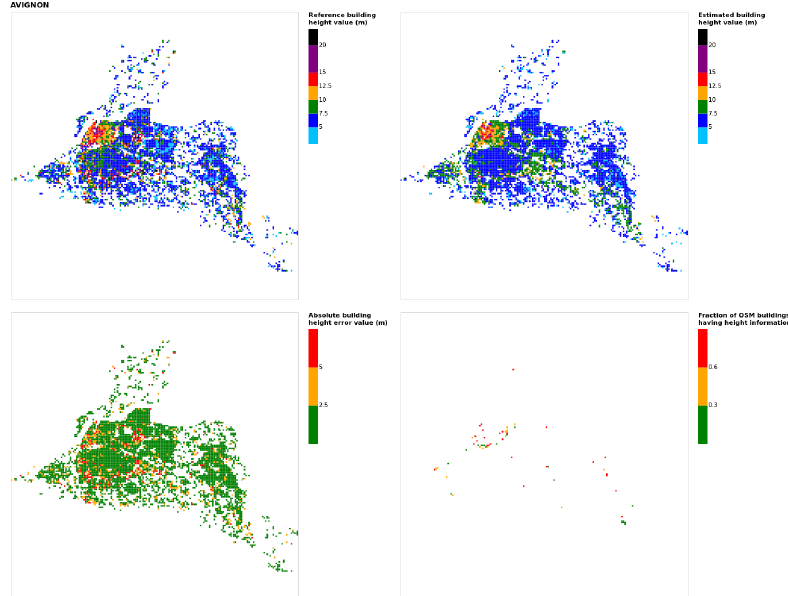
Figure B2. Results for the commune at grid cell (upper left panel) reference building height, (upper right panel) estimated building height, (lower left panel) absolute building height error, and (lower right panel) fraction of OSM buildings having height information. For all panels except the lower right, only cells that buildings – with at least 90% of their buildings having no height value in OSM – are displayed.